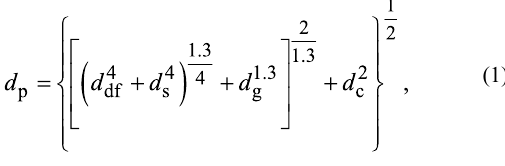
Table 1: Comparison of quantum mechanical wavelengths for ions and electrons. beam energy